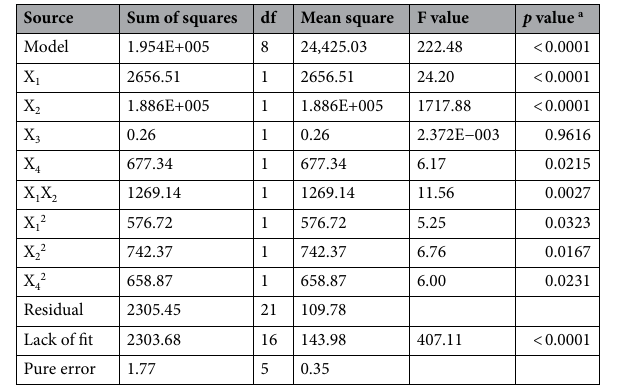
Table 5. Empirical design based on CCD applied in this paper. a Y Obs = Observed magnitudes of the secondary concentration of Cu (II) (mg L −1 ), Y Pre = Predicted values (mg L −1 ).